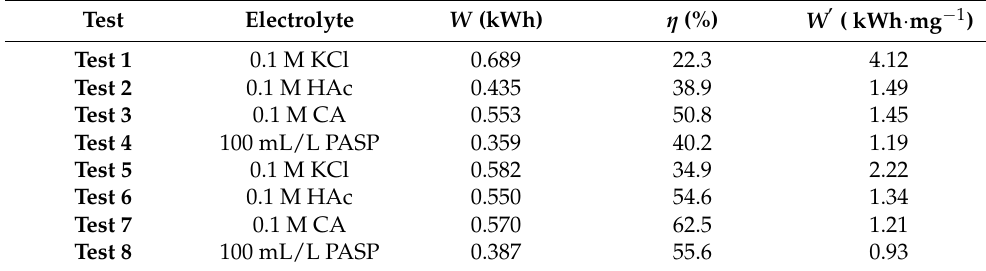
Table 3. Results of electrokinetic remediation of copper-contaminated